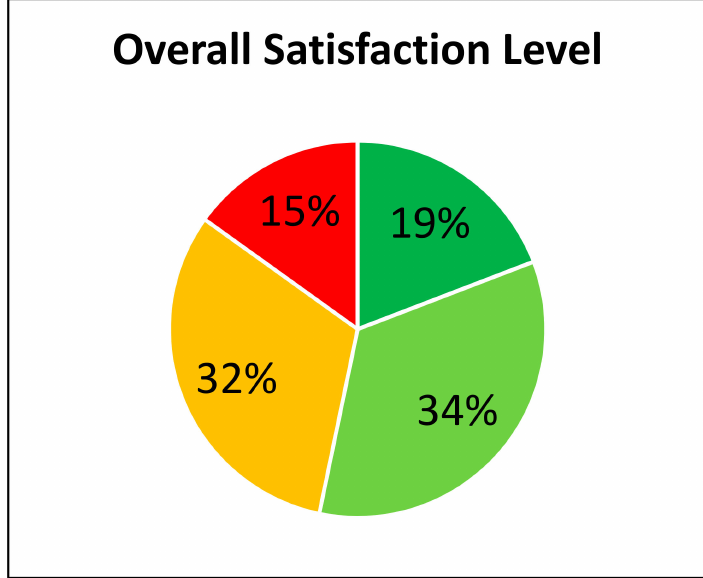
Figure 28. System generated overall satisfaction